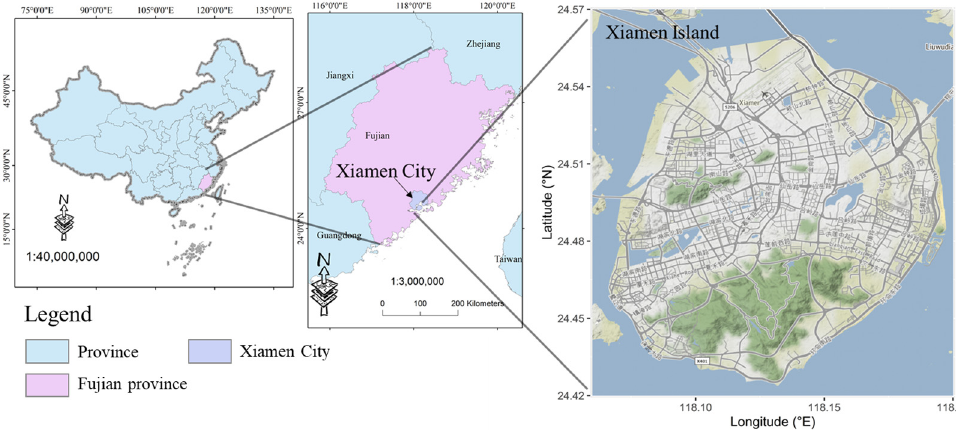
Figure 2. The location of the study area in this research. The left image is the study area location in China; the middle image is the Xiamen city location in Fujian province; and the right image is the Xiamen Island.